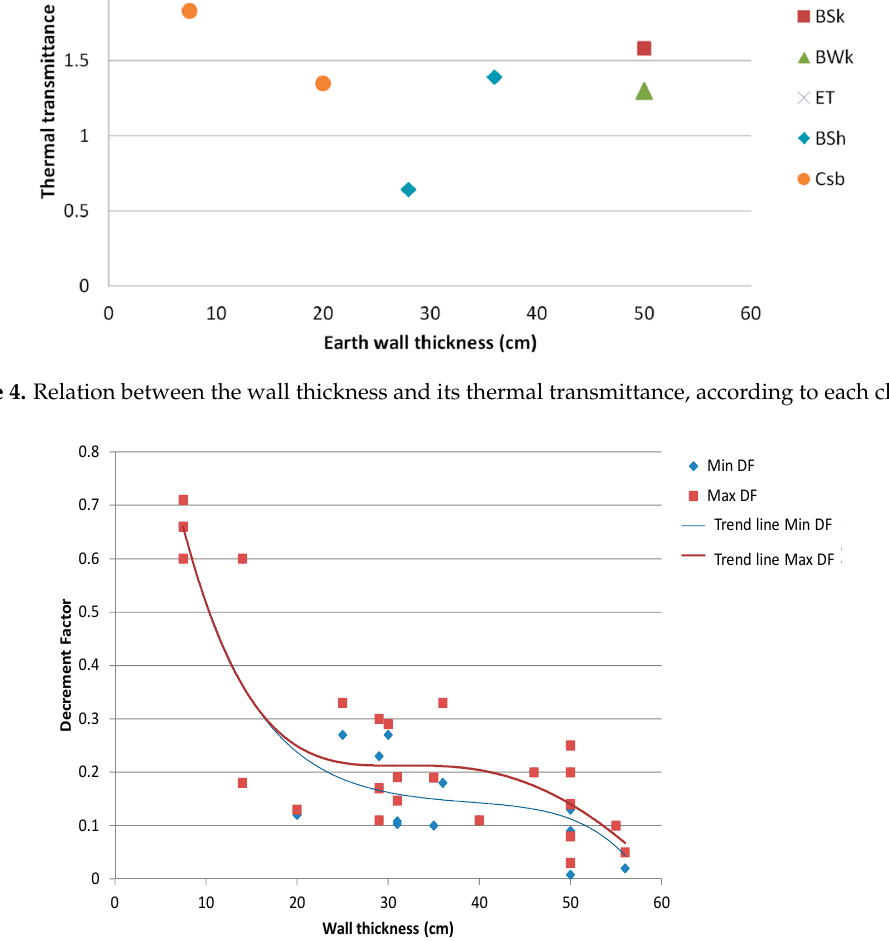
Figure 5. Decrement factor in function of the wall